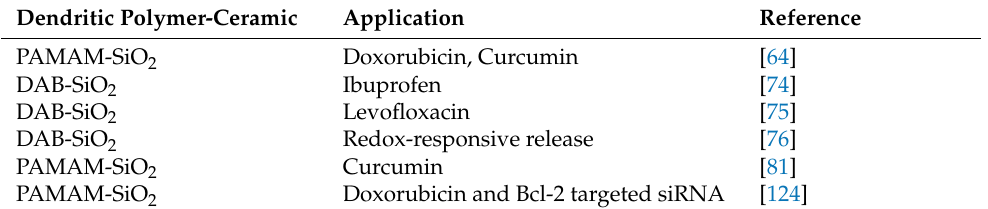
Table 5. Applications of ceramics/dendritic polymer composites in drug